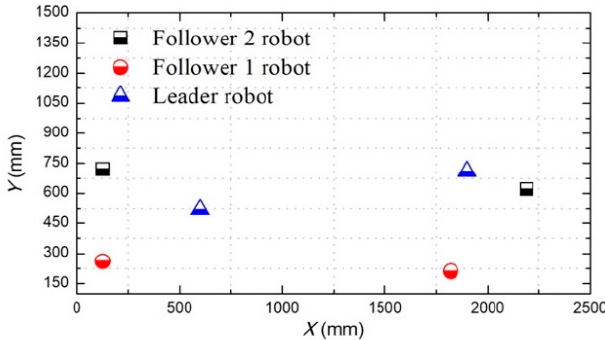
Figure 26. Calibration of the start and terminal coordinate (Interchange queue).